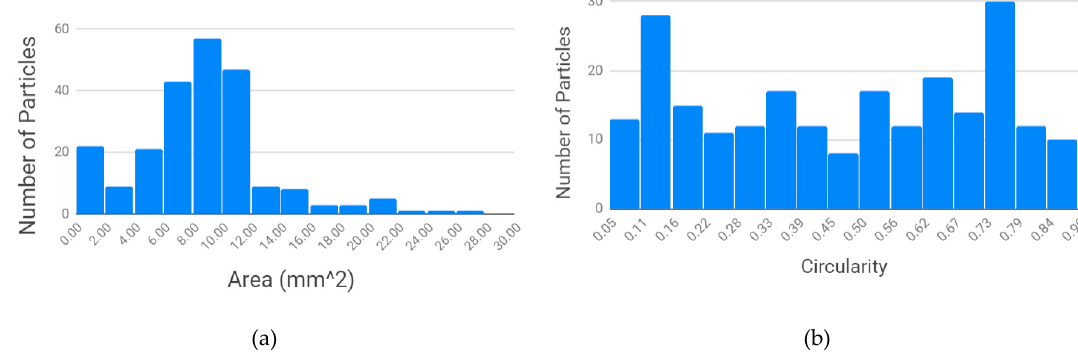
Figure 4. Ultrafuse rPET: particle size distribution ( a ) and particle circularity as a function of area ( b ).